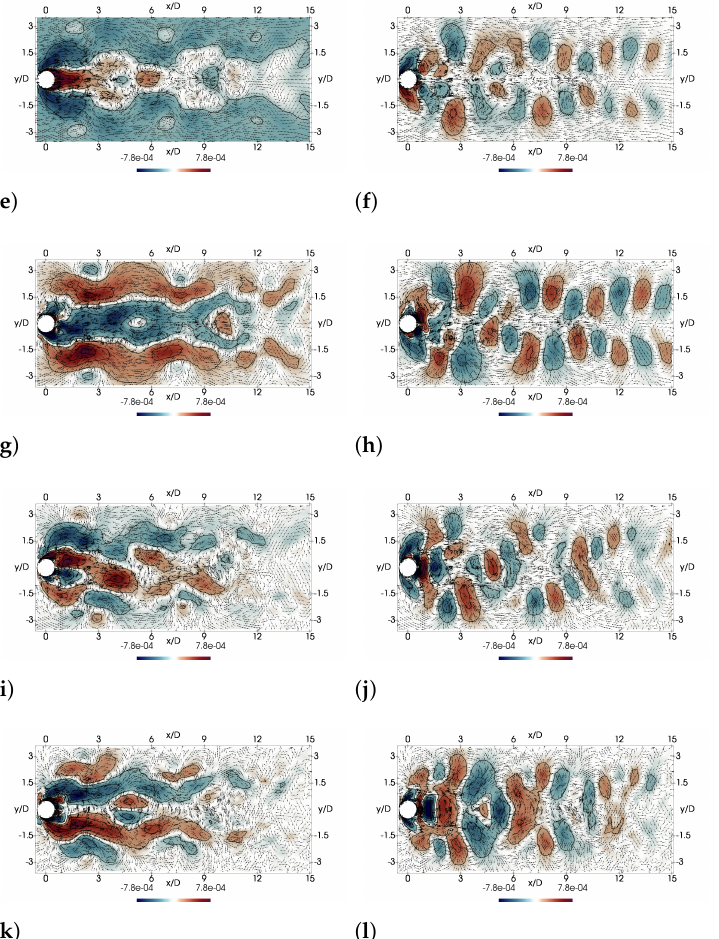
Figure 12. First six modes of the stream-wise ( a , c , e , g , i , k ) and cross-stream velocity ( b , d , f , h , j , l ) at the super-upper